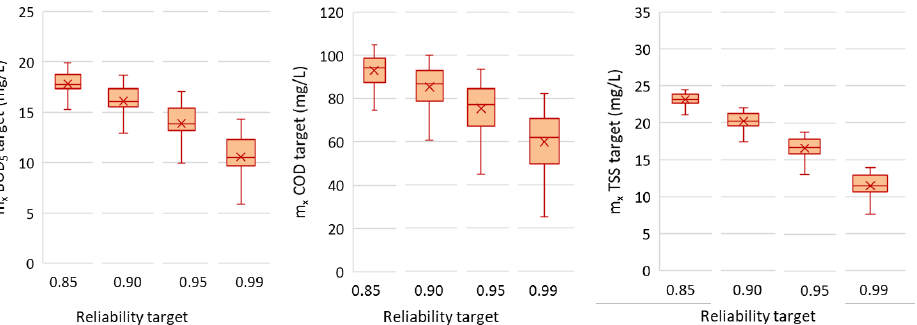
Figure 6. Target mean value (m x ) of BOD 5 , COD, and TSS effluent concentrations for achieving different reliability targets in 9 EA-WWTPs (5-year data).